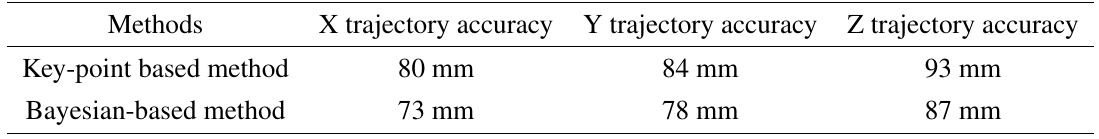
Table 2. A comparison of overall trajectory accuracy between key-point based method and Bayesian-based